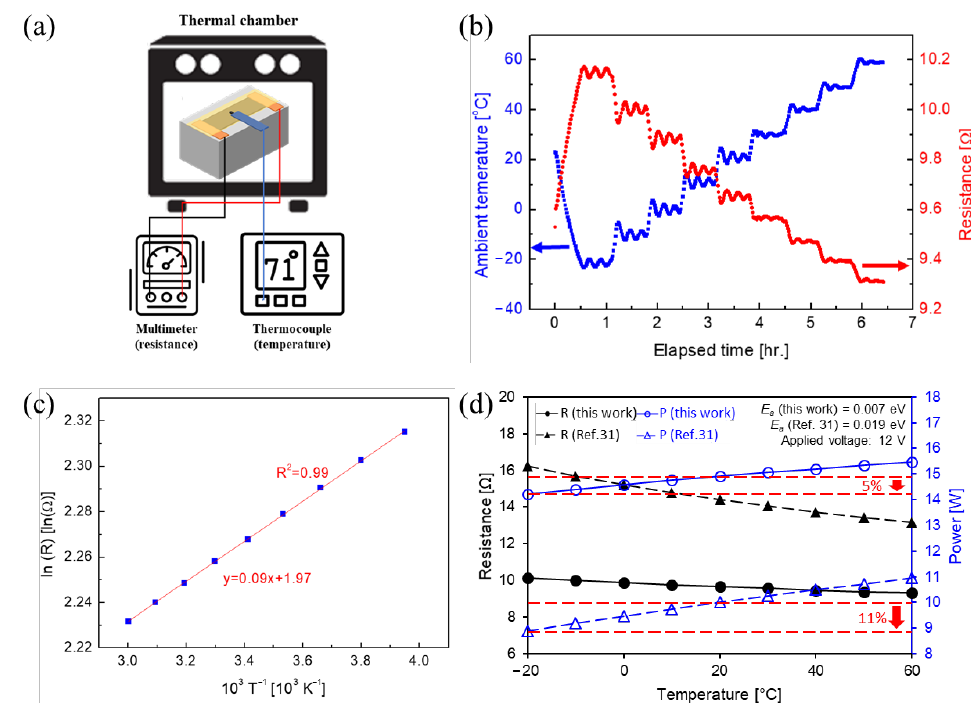
Figure 9. ( a ) Schematic of resistance-measurement setup for MWCNT/PDMS film on brick, depend- ing on ambient temperature. ( b ) Changes in ambient temperature and resistance of MWCNT/PDMS film, according to the elapsed time. ( c ) Arrhenius plot of MWCNT/PDMS film, depending on am- bient temperature. ( d ) Changes in theoretical resistance and power, according to temperature [31]. Reprinted/adapted with permission from Ref. [31]. Copyright 2016, copyright AIP Publishing